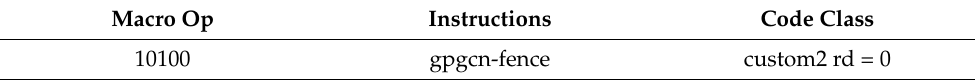
Table 6. The fence instruction extension.